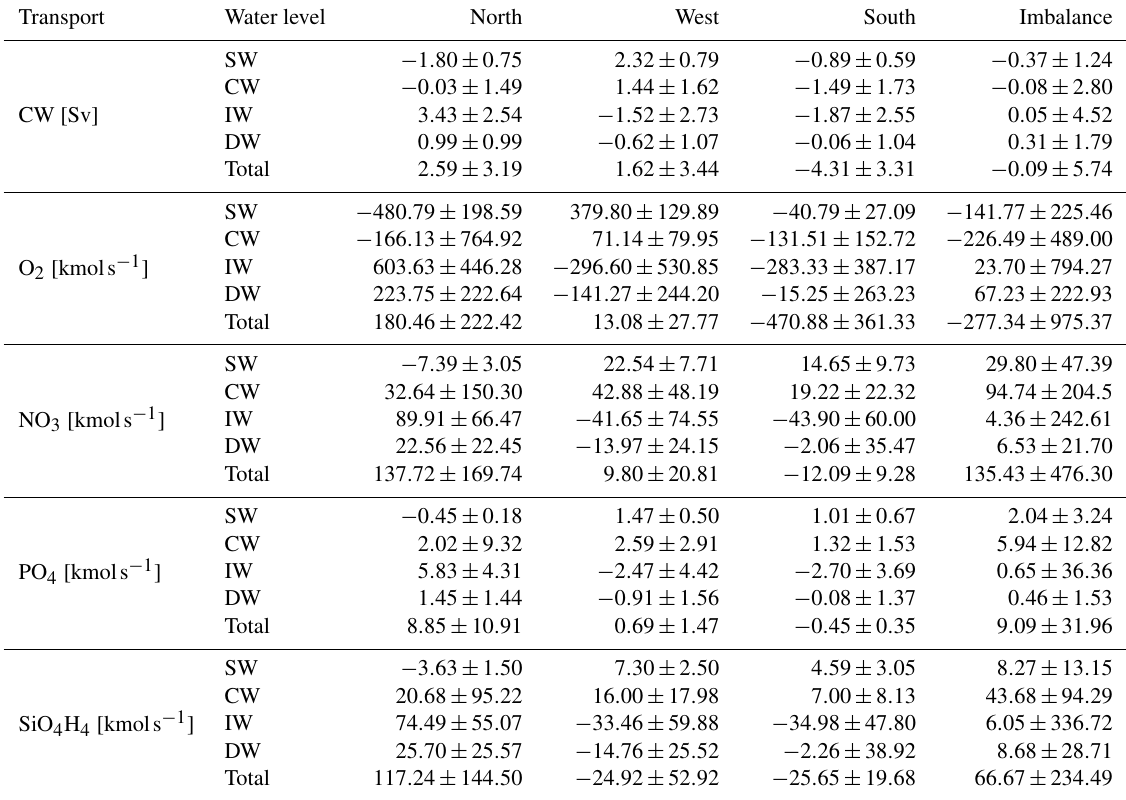
Table 2. Mass transports and their errors (in Sv), and transports of O 2 , NO 3 , PO 4 and SiO 4 H 4 (in kmols − 1 ) with their errors relative to mass transport for SW, CW, IW and DW across the northern, western, southern and eastern transects for the FLUXES-I cruise (with WOA stations). Positive (negative) values indicate outward (inward) transports. The total row of each inorganic nutrient or O 2 is its integrated transport throughout the whole water column. The last column is the maladjustment or imbalance of each water level.